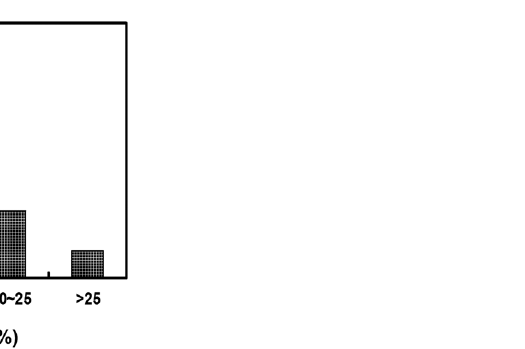
Figure 3. Frequency distribution of grain yield increase rate of the + K treatment compared to –K treatment for the 54